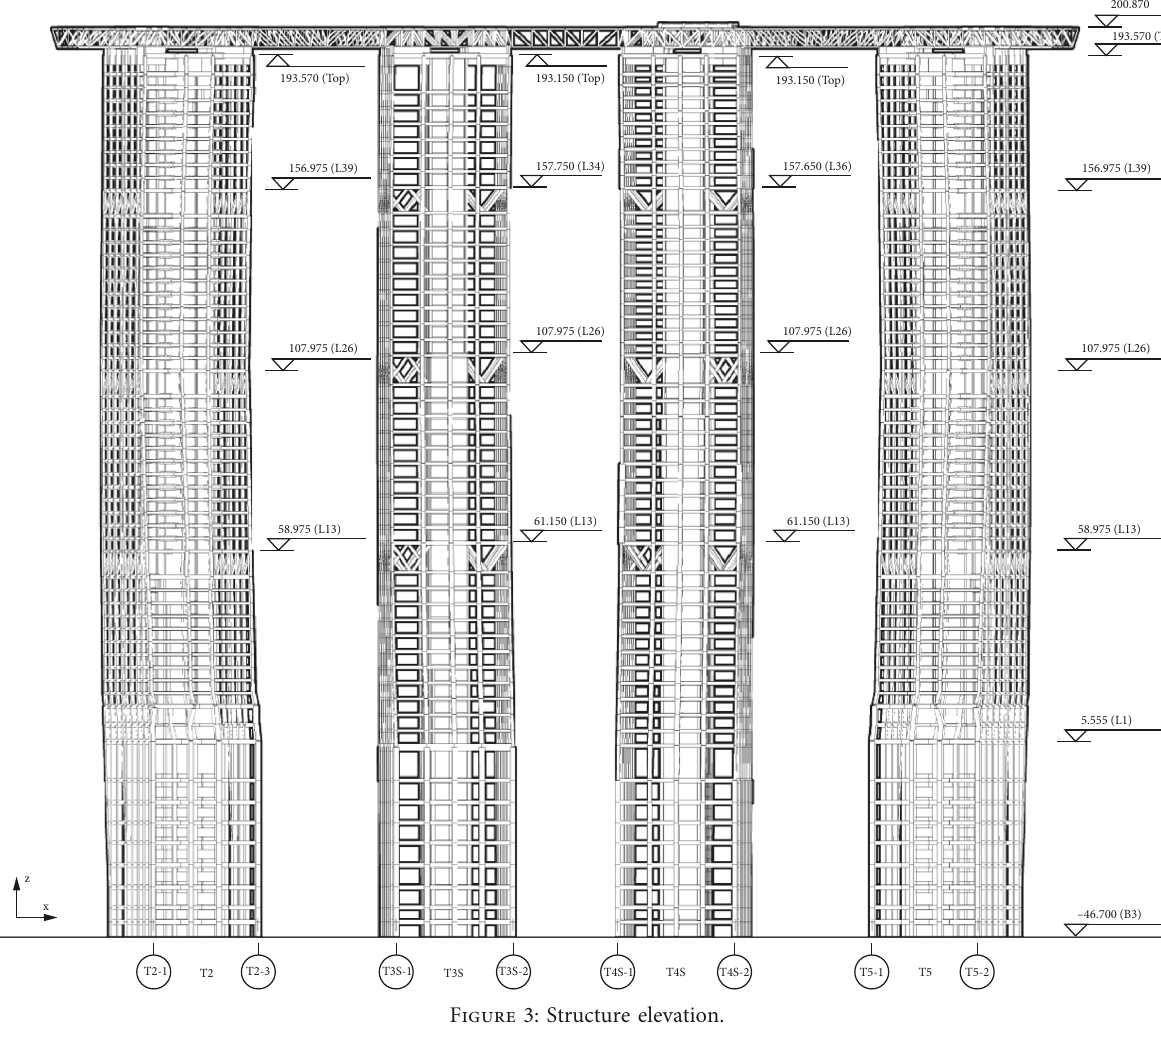
Figure 3: Structure